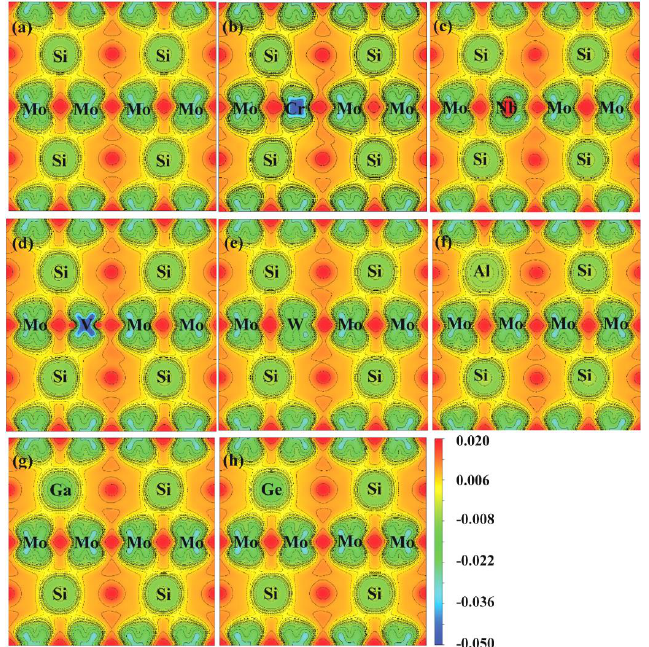
Figure 9. Deformation charge densities of undoped and doped Mo 3 Si. ( a ) Undoped; ( b ) Cr; ( c ) Nb; ( d ) V; ( e ) W; ( f ) Al; ( g ) Ga; ( h ) Ge.